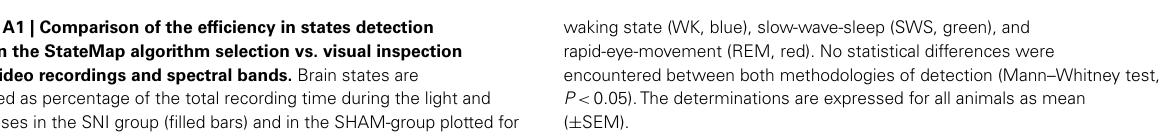
FIGUREA1 | Comparison of the efficiency in states detection between the StateMap algorithm selection vs. visual inspection of the video recordings and spectral bands. Brain states are expressed as percentage of the total recording time during the light and dark phases in the SNI group (filled bars) and in the SHAM-group plotted for